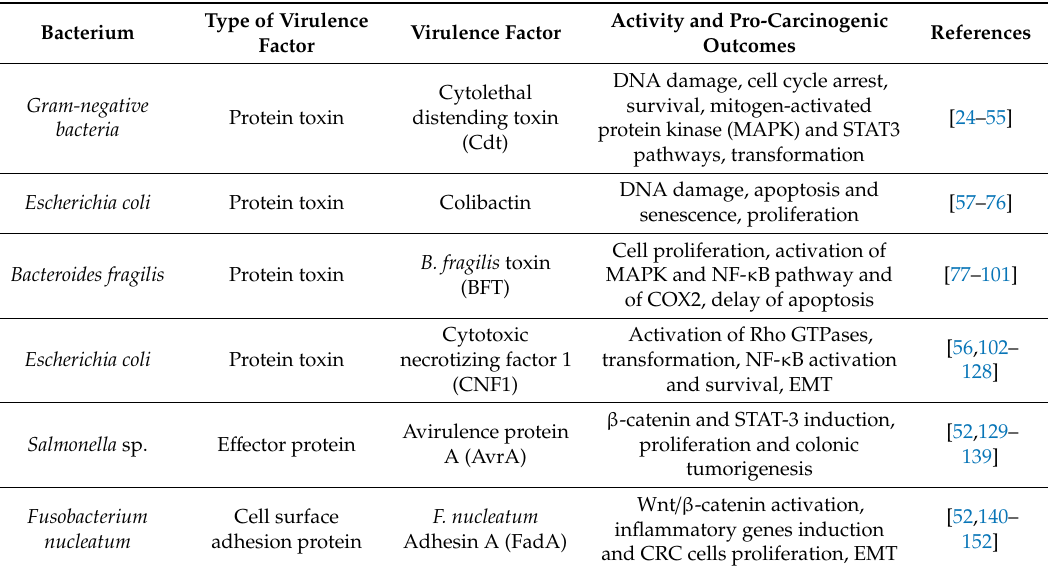
Table 1. Bacterial virulence factors indicated as CRC